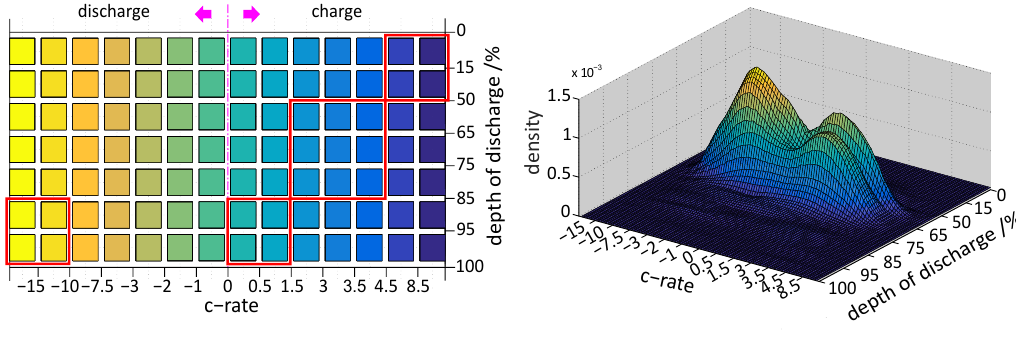
Figure 8. Example of extrapolating load collectives by a certain kernel-type